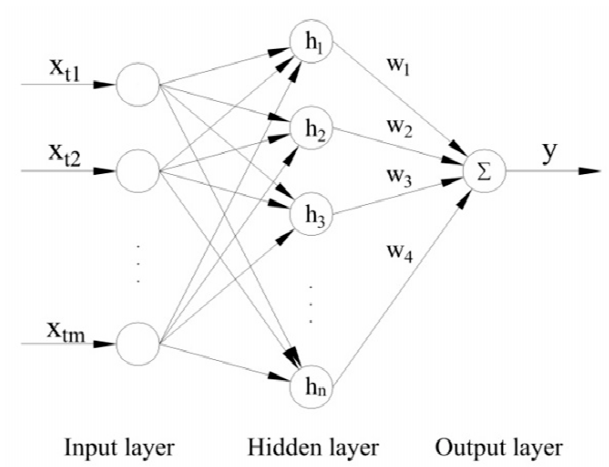
Figure 13. The schematic diagram of the Radial Basis Function (RBF) neural network.